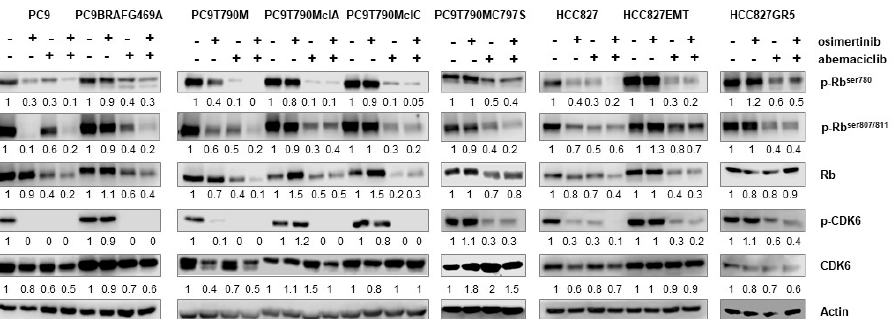
Figure 4. Effect of abemaciclib alone or combined with osimertinib on cell cycle proteins in NSCLC osimertinib resistant cell lines. Cells were treated with osimertinib (50 nM for sensitive and 500 nM for resistant cells), abemaciclib (500 nM) or their combination and after 24h were lysed and western blot analysis was performed to detect the indicated proteins. Results are representative of at least two independent